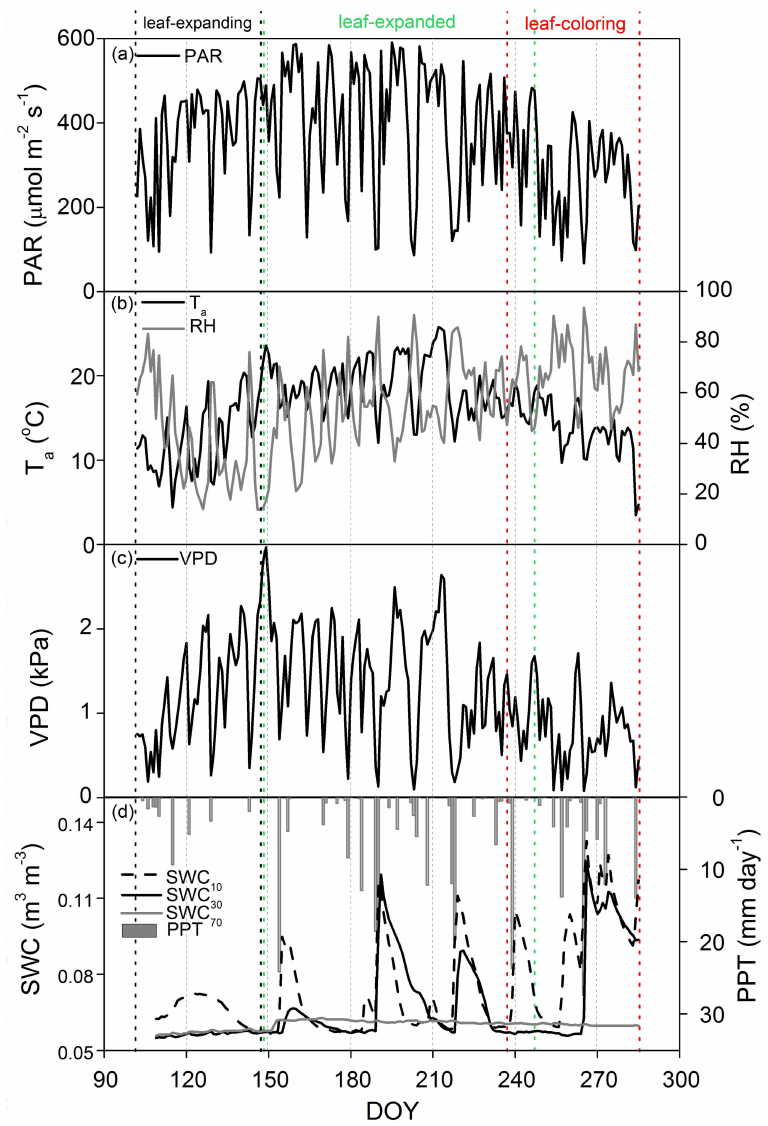
Figure 1. Time series of meteorological variables: daily mean incident photosynthetically active radiation (PAR, ( a )), air temperature (T a , ( b )), relative humidity (RH, ( b )), atmospheric vapor pressure deficit (VPD, ( c )), soil water content (SWC, ( d )) at three soil depths (10, 30, and 70 cm), and daily-cumulated rainfall (PPT, ( d )) during the growing season (DOY 102 to 285) of 2014. Black, green, and red vertically dotted lines represent leaf-expanding, expanded, and coloring